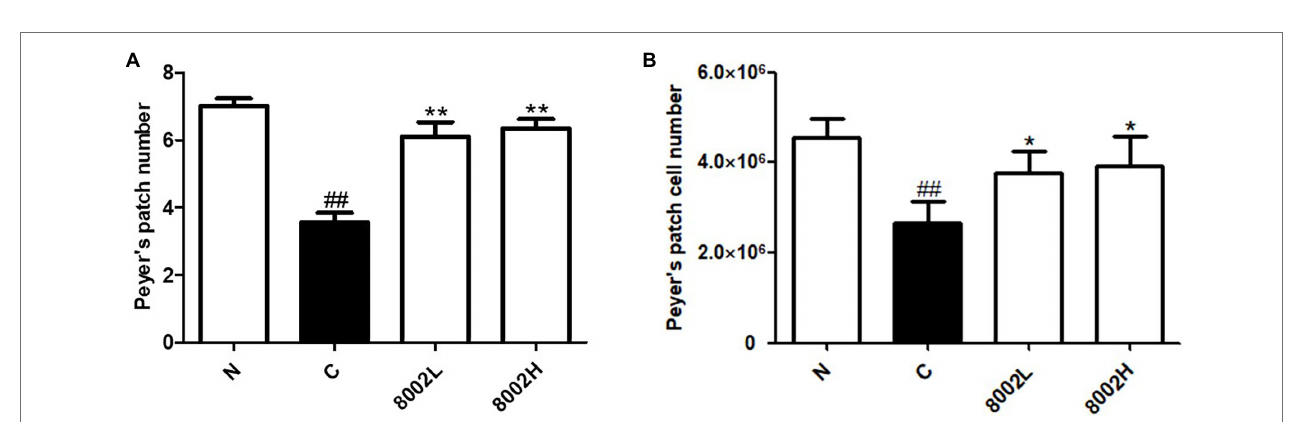
FIGURE 6 | Effect of HY8002 administration on the composition of Peyer’s patch structures, including (A) number of Peyer’s patches and (B) total number of Peyer’s patch cells in kanamycin-treated mice. The results are expressed as the mean ± SEM. * p < 0.05 and ** p < 0.01 compared with kanamycin-treated control groups. ## p < 0.01 compared with normal groups. N, normal group ( n = 8); C, kanamycin administration group ( n = 8); 8002L, kanamycin with 1.0 × 10 8 CFU/kg/day HY8002 administration group ( n = 8); 8002H, kanamycin with 1.0 × 10 9 CFU/kg/day HY8002 administration group ( n =